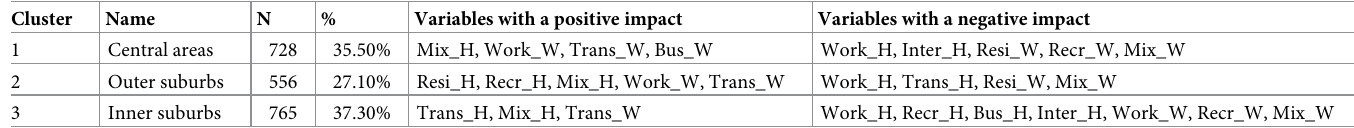
Table 6. Cluster